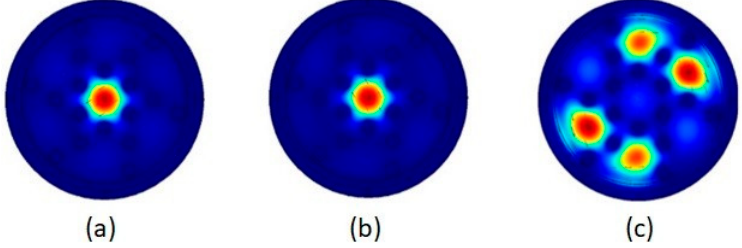
Figure 3. ( a ) X-polarized core mode ( b ) Y- polarized core mode ( c ) SPP mode.